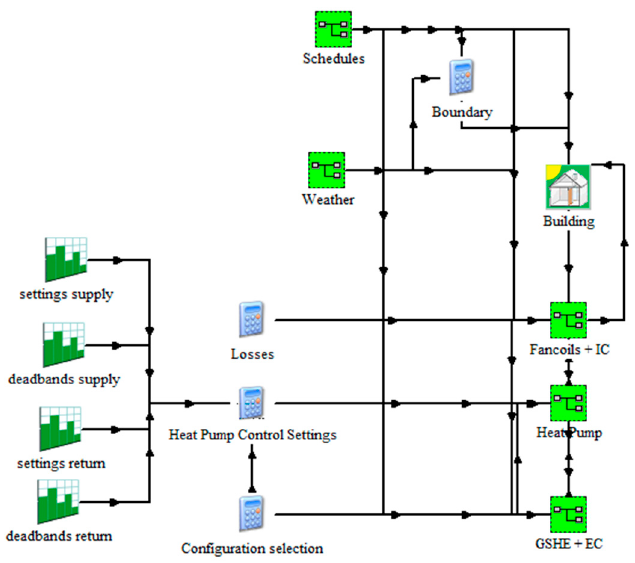
Figure 7. Complete TRNSYS model for the GSHP system.